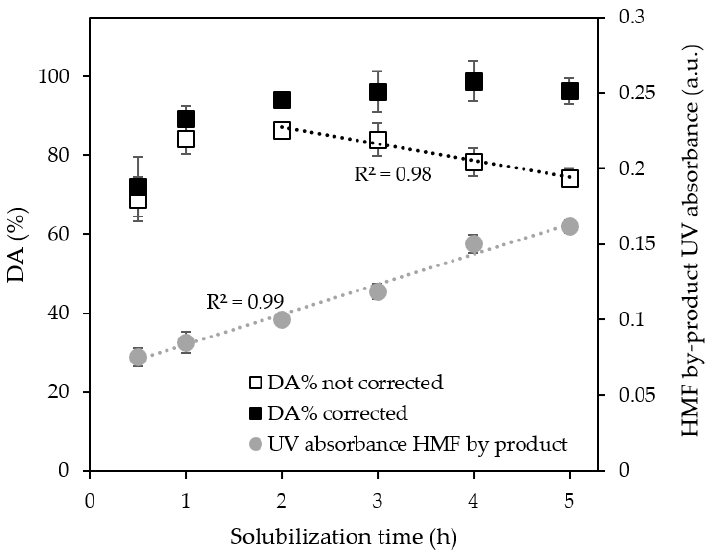
Figure 3. HMF formation upon solubilization of ChNC and its effect on the measured degree of acetylation (samples incubated for 24 h).